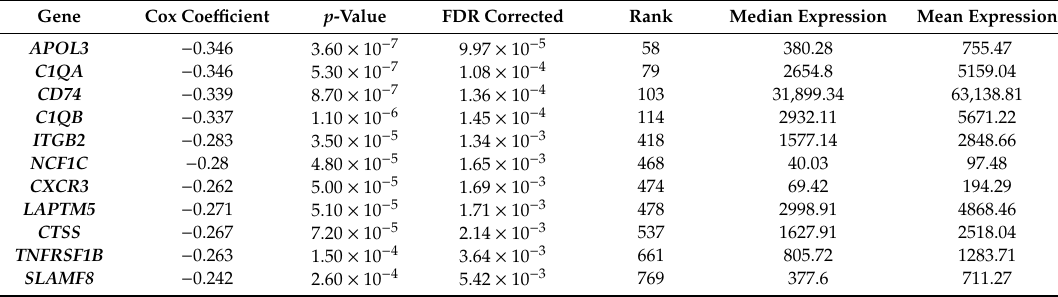
Table 7. Association of 11 HLA class II co-expressed genes in cutaneous melanoma with survival generated from Cox regression analysis via